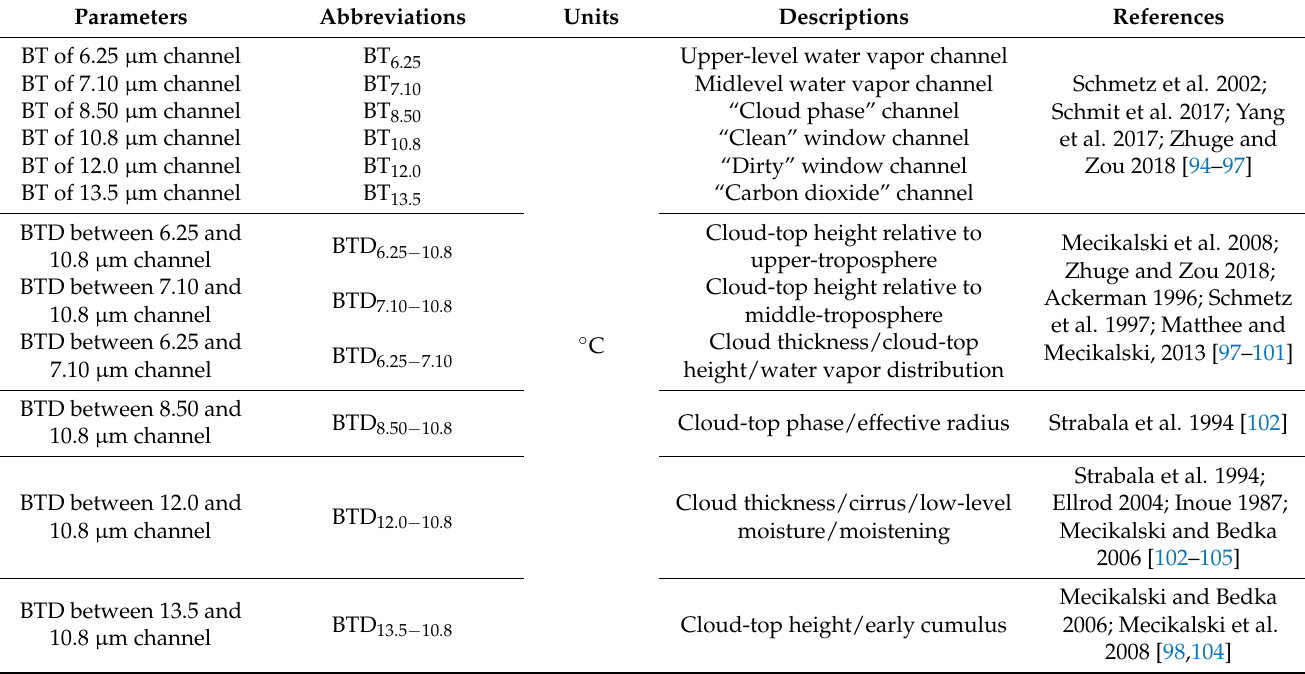
Table 3. List of cloud-top parameters.